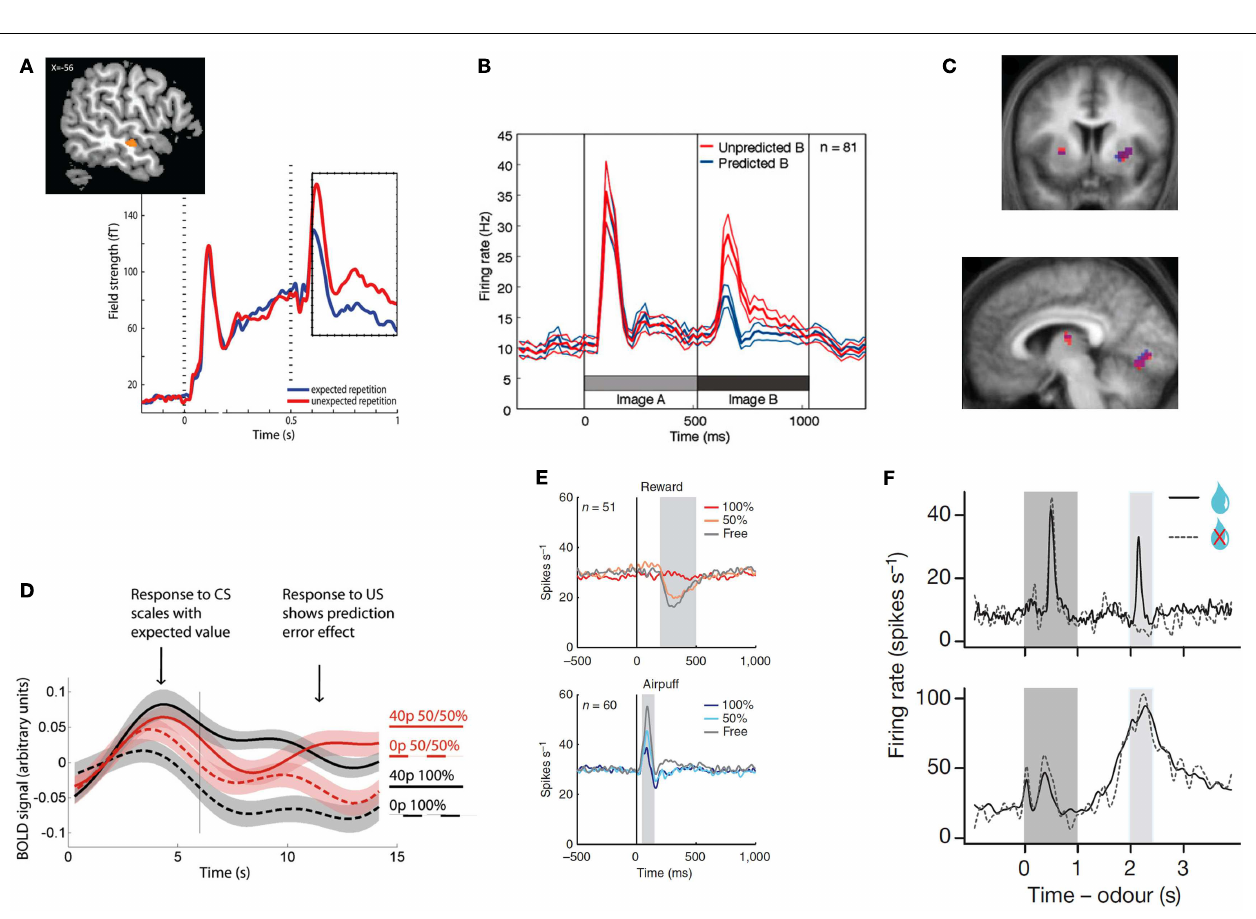
FIGURE 1 |Top row: examples of unsigned prediction errors. (A) MEG: larger evoked activity in the auditory cortex for repeated but unexpected auditory stimuli. Reprinted from (Todorovic et al., 2011) with permission from the authors. (B) Single-unit recordings: larger population firing rate in the inferotemporal cortex for unexpected images. Reprinted from (Meyer and Olson, 2011) with permission from the authors. (C) fMRI: correlation between the degree of surprise evoked by a (present or absent) visual stimulus and striatal (top and bottom left) and primary visual (bottom right) hemodynamic activity. Reprinted from (den Ouden et al., 2009) with permission from the authors. Bottom row: examples of signed prediction errors: (D) fMRI: increased hemodynamic activity in theVTA for outcomes that are better than expected, but decrease for worse than expected. Reprinted from (Klein-Flugge et al., 2011), copyright (2011) with